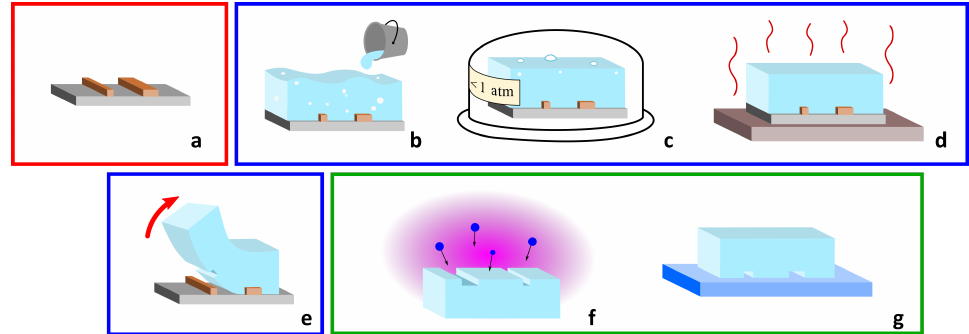
Figure 1. Procedure for PDMS microfluidic device realization: first, the negative mold of the desired fluidic network is realized using, for instance, lithographic techniques ( a ); as a second step, the network is replicated on the PDMS: the liquid elastomer is poured on the mold ( b ), then, it is degassed under a low vacuum chamber ( c ), it is cured on a hotplate ( d ), and finally, it is peeled off the mold ( e ); last, the PDMS is bonded on a sealing substrate, for instance, glass: the surface is activated using a plasma treatment ( f ), and then, the whole devices is permanently assembled ( g